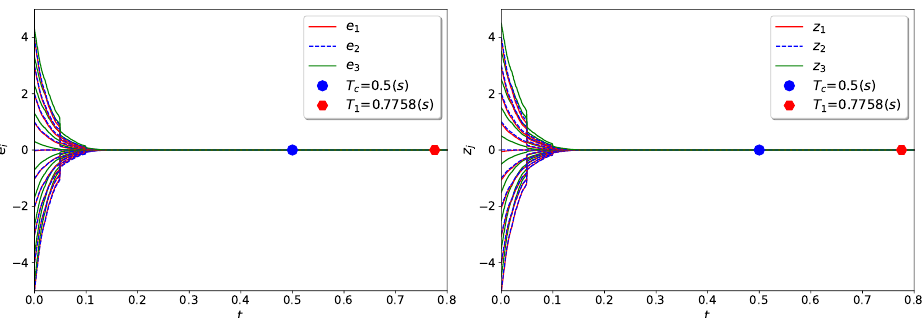
Figure 5. Evaluation of synchronization errors for Example 2.